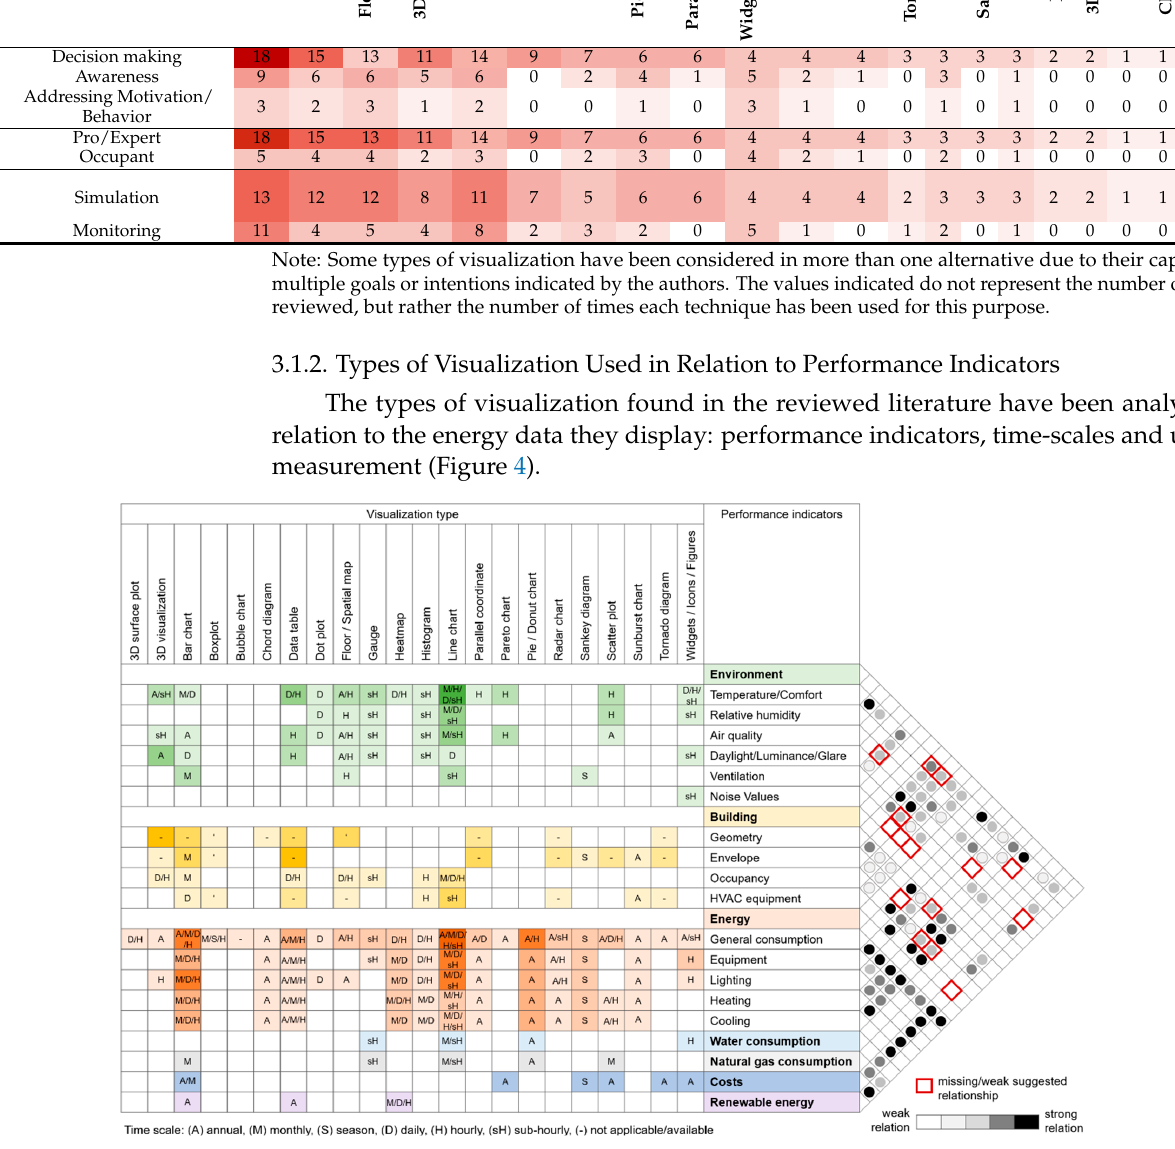
Figure 4. Visualization types in relation to building performance indicators and